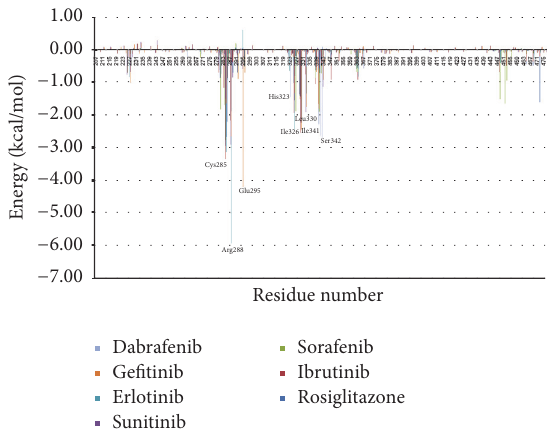
Figure 6: Energy contribution for individual residues 207–476 of human PPAR 𝛾 complexes with KIs and rosiglitazone to the overall free energy at 25 ns MD